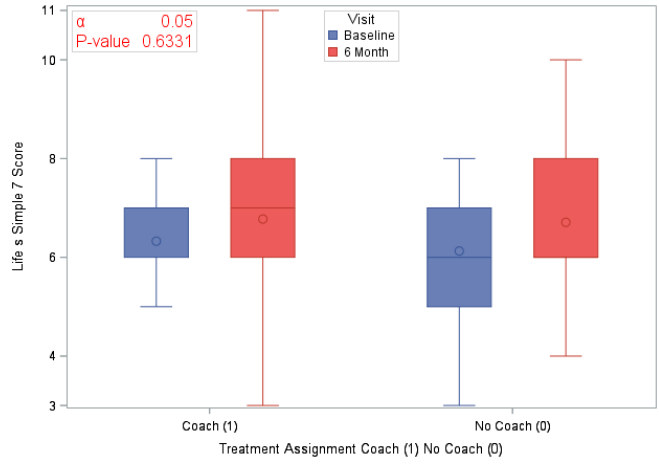
Figure 3. Life’s Simple 7 by study visit and randomization group.